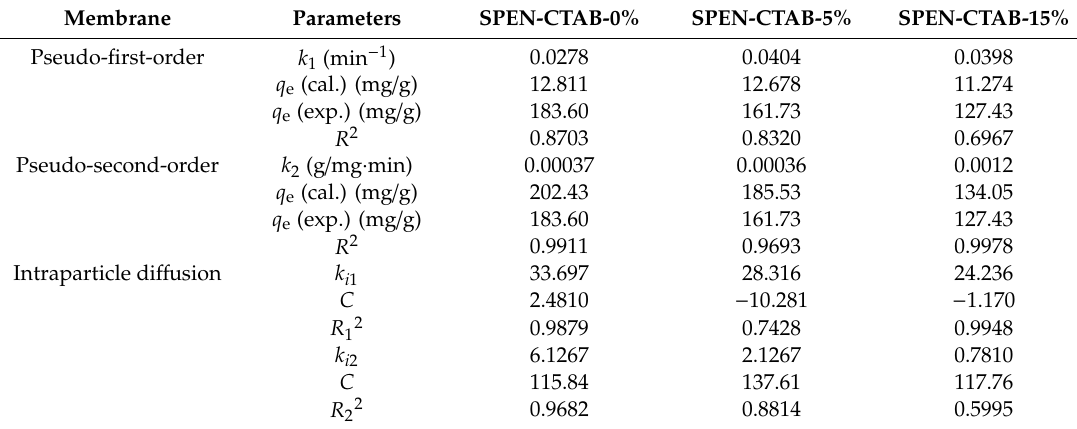
Table 2. The kinetic parameters of adsorption of Pb(II) onto SPEN-CTAB-0%, SPEN-CTAB-5% and